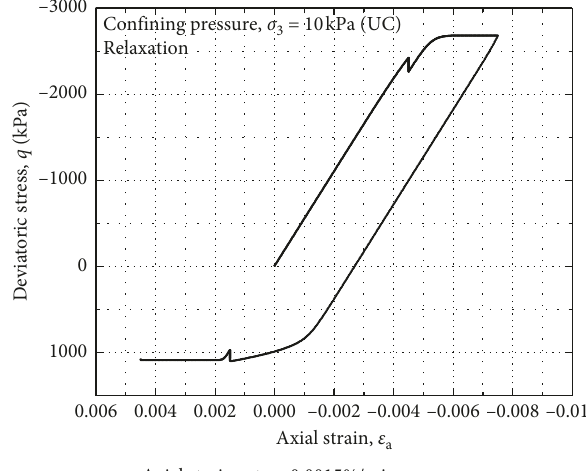
Figure 10: Deviatoric stress versus axial strain for a single strain rate under a single confining stress of 10kPa. Displacement control cyclic relaxation analysis is done in both compression and ex- tension